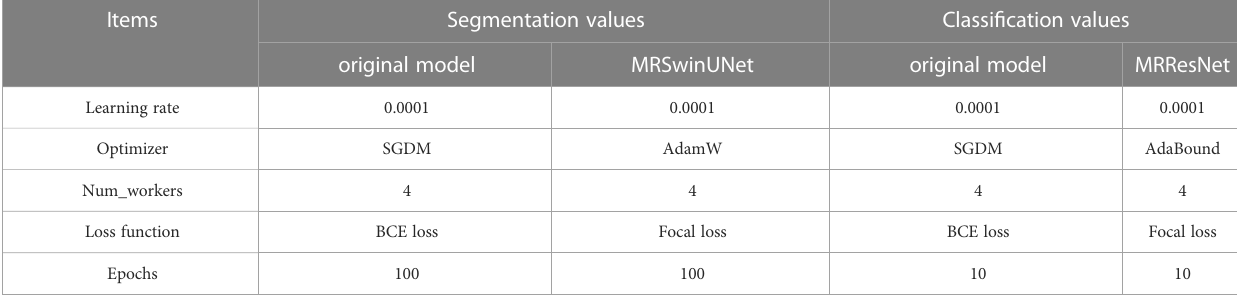
TABLE 1 The segmentation and classi fi cation network model training